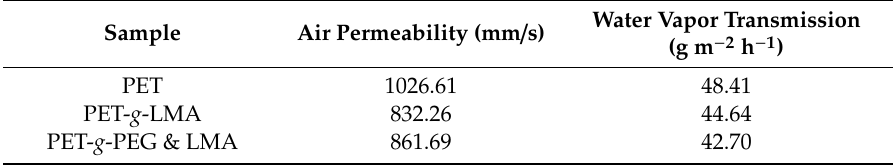
Table 2. The air permeability and water vapor transmission of di ff erent PET